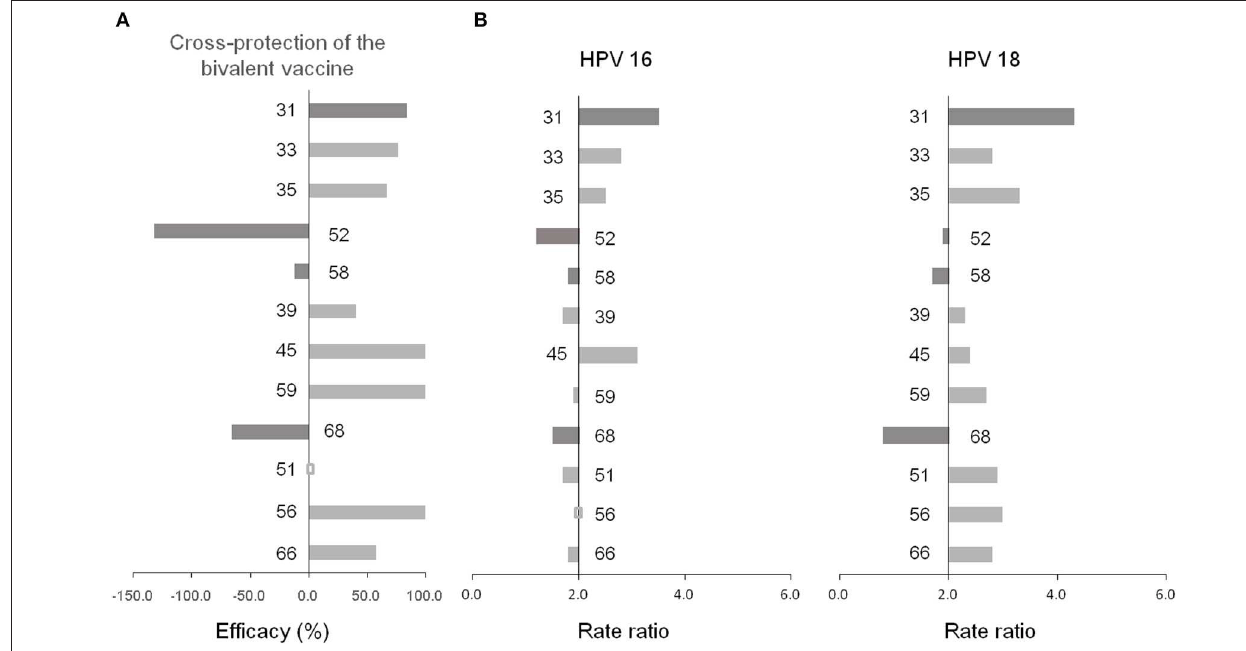
FIGURE 4 | (A) Cross-protection of the bivalent vaccine (14). (B) Co-infection preference of 14